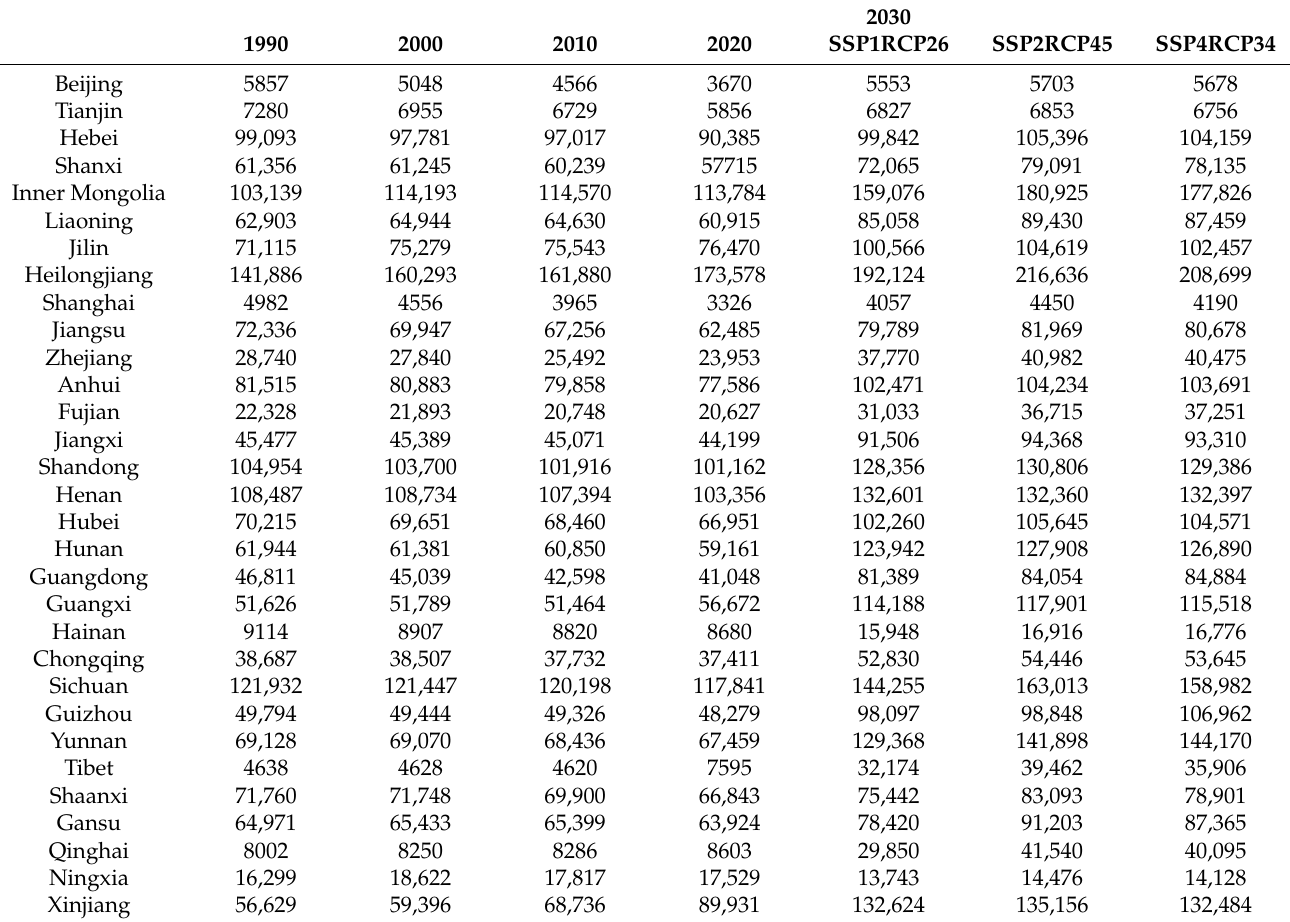
Table 5. Amount of cropland in each province from 1989 to 2030, unit: Km 2